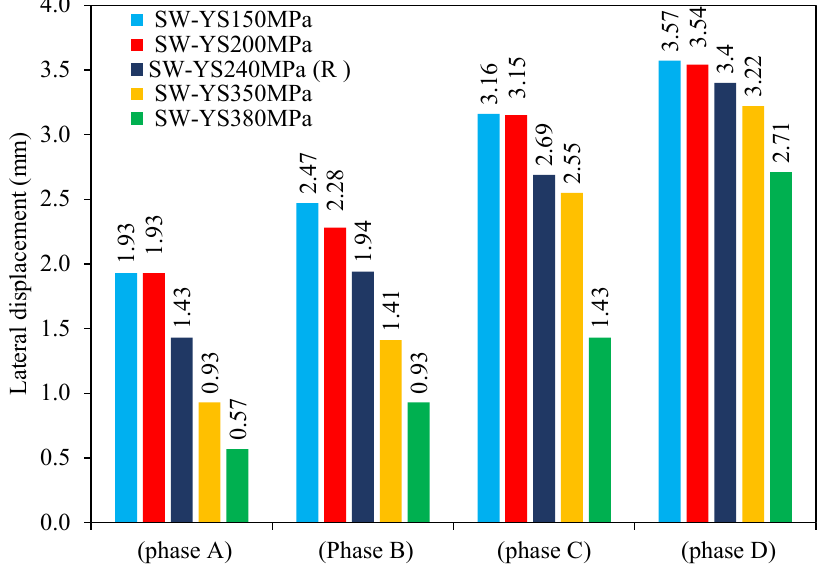
Figure 18. Lateral displacement of group 3.